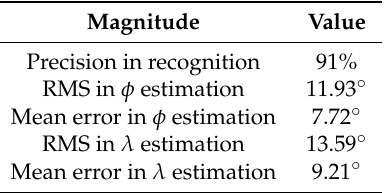
Table 4. Summary of recognition and pose estimation results.